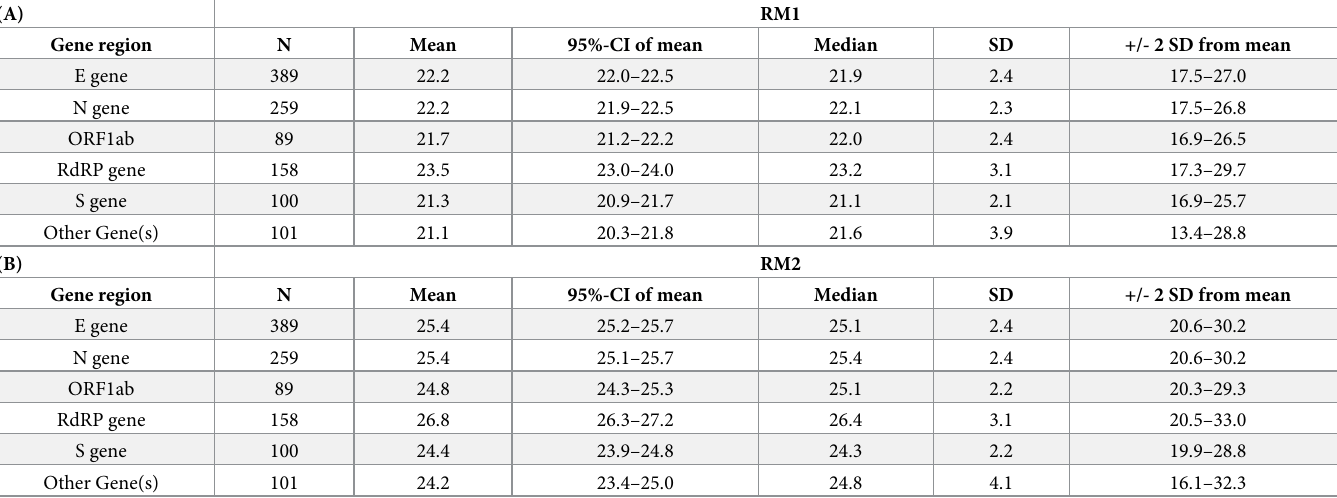
Table 2. Statistical information (mean, median, 95%-CI of mean) on Ct value distribution per gene region for RM 1 and RM